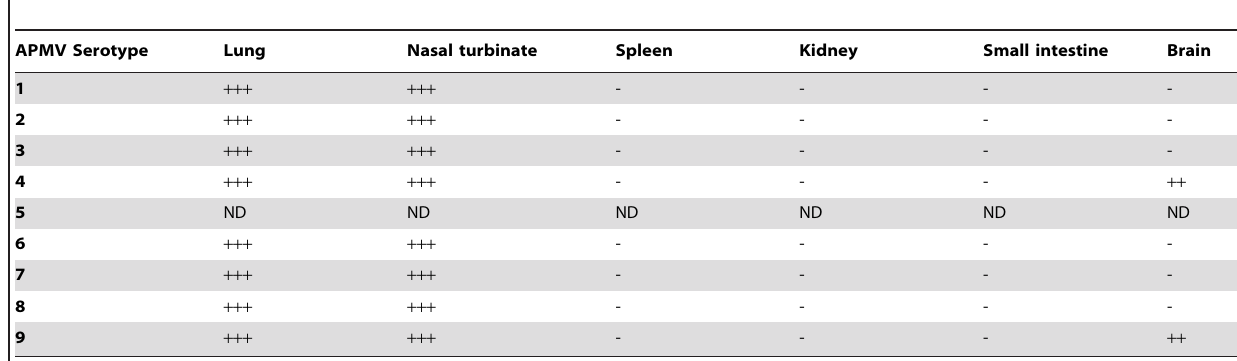
* Mice in groups of 3 were inoculated with 50 ı`l of allantoic fluid containing 2 7 HA units of each APMV serotype except serotype 5, which contained 3 6 10 3 PFU/ml of cell culture harvested virus. The control group was inoculated with normal allantoic fluid. Tissues were harvested 3 dpi and homogenized, and clarified supernatant fluid was inoculated into 9-day-old embryonated eggs and tested for virus 4 days later by HA assay. + =each + indicates isolation of virus from one mice. - =no virus was isolated. ND=not detected.